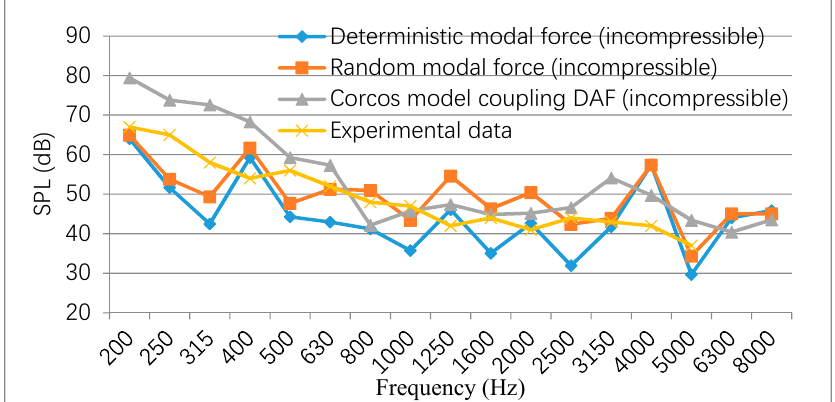
Figure 28. Comparisons of the results of BEM coupling three methods of incompressible numerical simulation and experimental result.